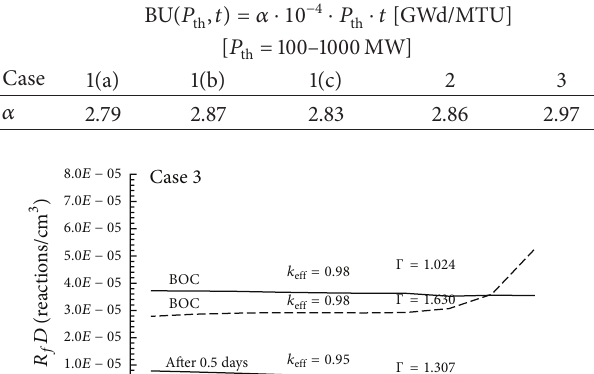
Table 4: Increase of burn-up with the thermal power and time.